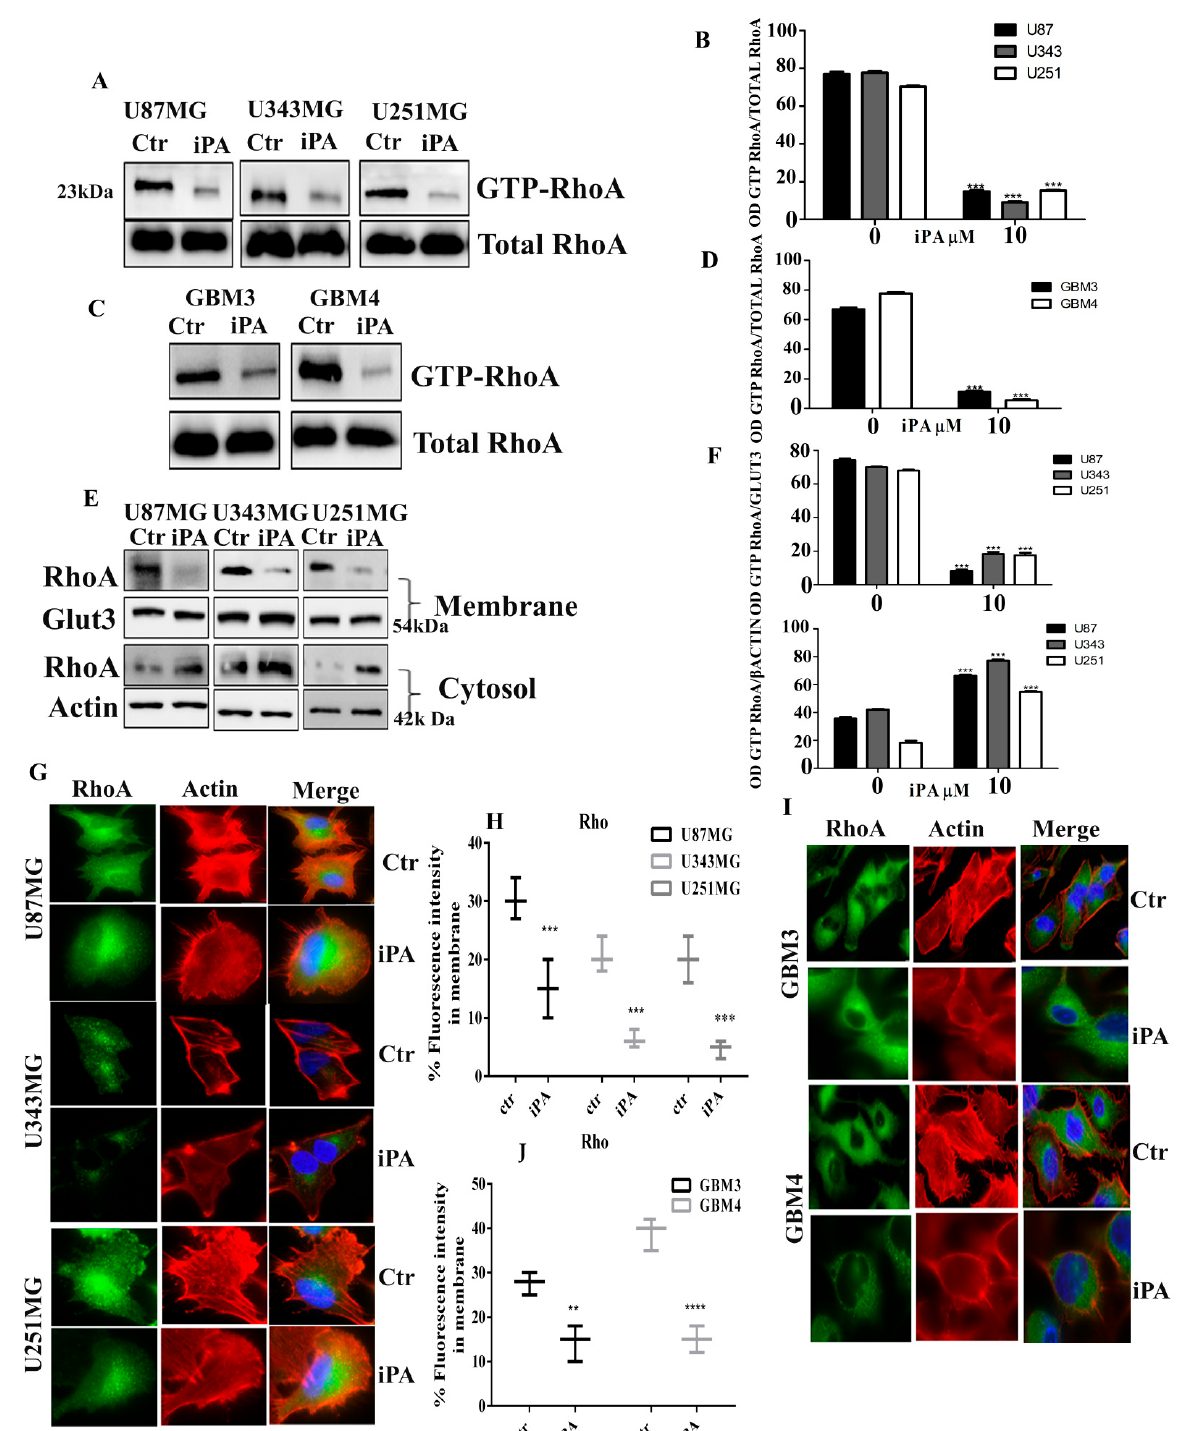
Figure 5. Effect of iPA on RhoA GTPase activity. Western Blot analysis showing the reduction in GTP-RhoA levels in iPA treated ( A ) U87MG, U251, U343 cells and ( C ), GMB primary cells line (GBM 3; GMB 4) at 18 h. ( E ) Western Blot analysis showing RhoA protein levels in membrane/cytosol fractions obtained from iPA treated and untreated GBM stabilized cell lines at 18 h. ( B , D , F ) Densitometric analysis of each Western Blot panel. Immunofluorescence staining of RhoA (green signal) and Actin (red signal, Phalloidin) in iPA treated and untreated. ( G ) GBM stabilized and ( I ) primary cell lines at 18 h. The Merge panel shows the overlapping of the two signals (green signal + red signal): in iPA treated cells, RhoA is reduced from the membrane. ( H , J ) The rate of F-actin was quantified and data are plotted as boxplots. Results are expressed as the mean ± SD of four independent experiments conducted in triplicate. (ANOVA, ** p < 0.01, *** p < 0.001, **** p <